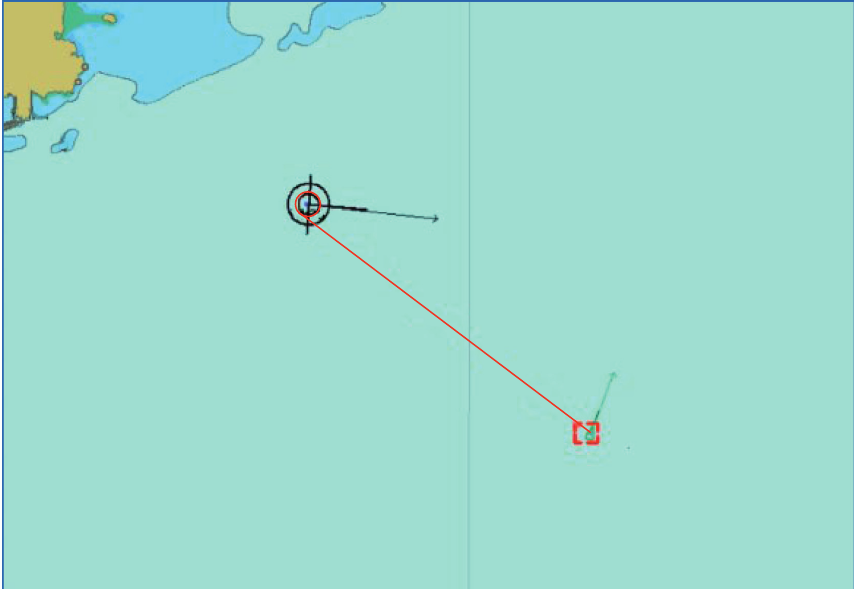
Figure 27: Own ship is a give way